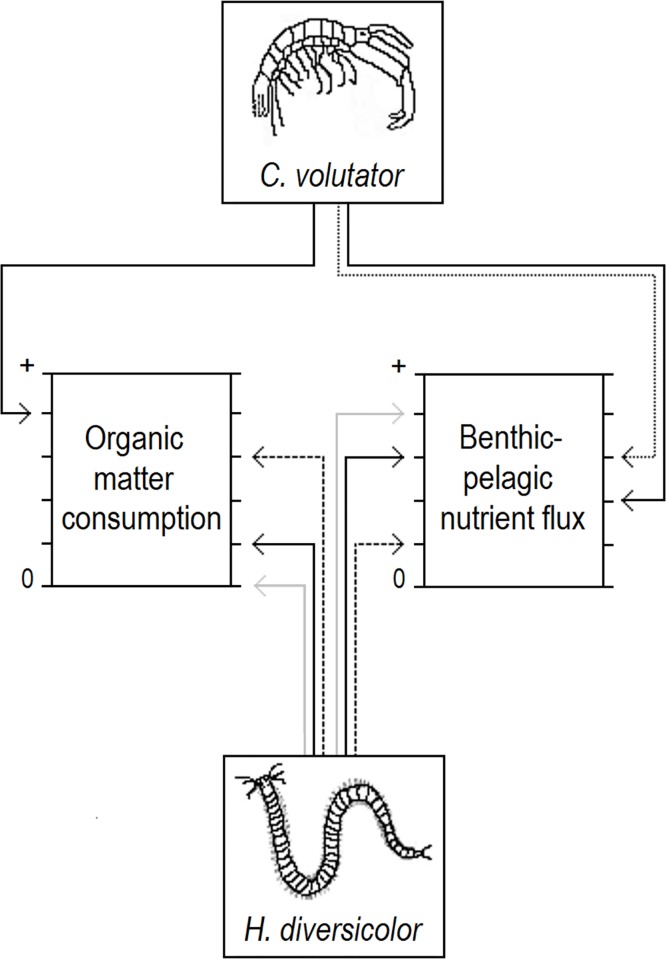
Illustration of hypotheses.The predicted effects that increasing the densities of Corophium voluator and Hediste diversicolor will have on organic matter consumption and benthic-pelagic nutrient flux, from 0 (no effect) toward an increasingly positive effect. The solid black lines represent predictions based on the biological traits of C. volutator and H. diversicolor. For C. volutator, the dotted line represents how an interaction with H. diversicolor may enhance its effect on nutrient flux. For H. diversicolor, the dashed lines represent how an interaction with C. volutator may enhance its effect on organic matter consumption and reduce its effect on nutrient flux; whereas the grey lines represent how a different interaction with C. volutator may reduce its effect on organic matter consumption and enhance its effect on nutrient flux.